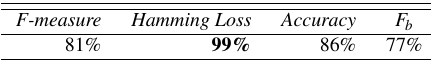
Table 4: Average similarity of the feature subsets X (cid:6)